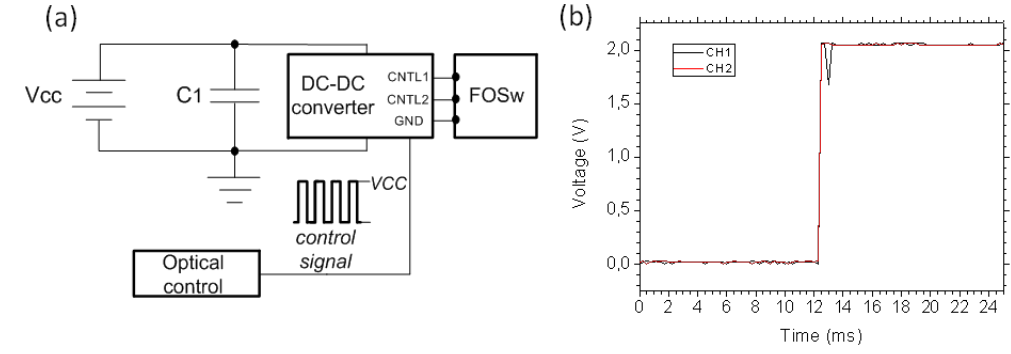
Figure 2. ( a ) Electronics setup for the remote control of the fiber optic switch; ( b ) Zoom of the switch rising flank response for both channels.